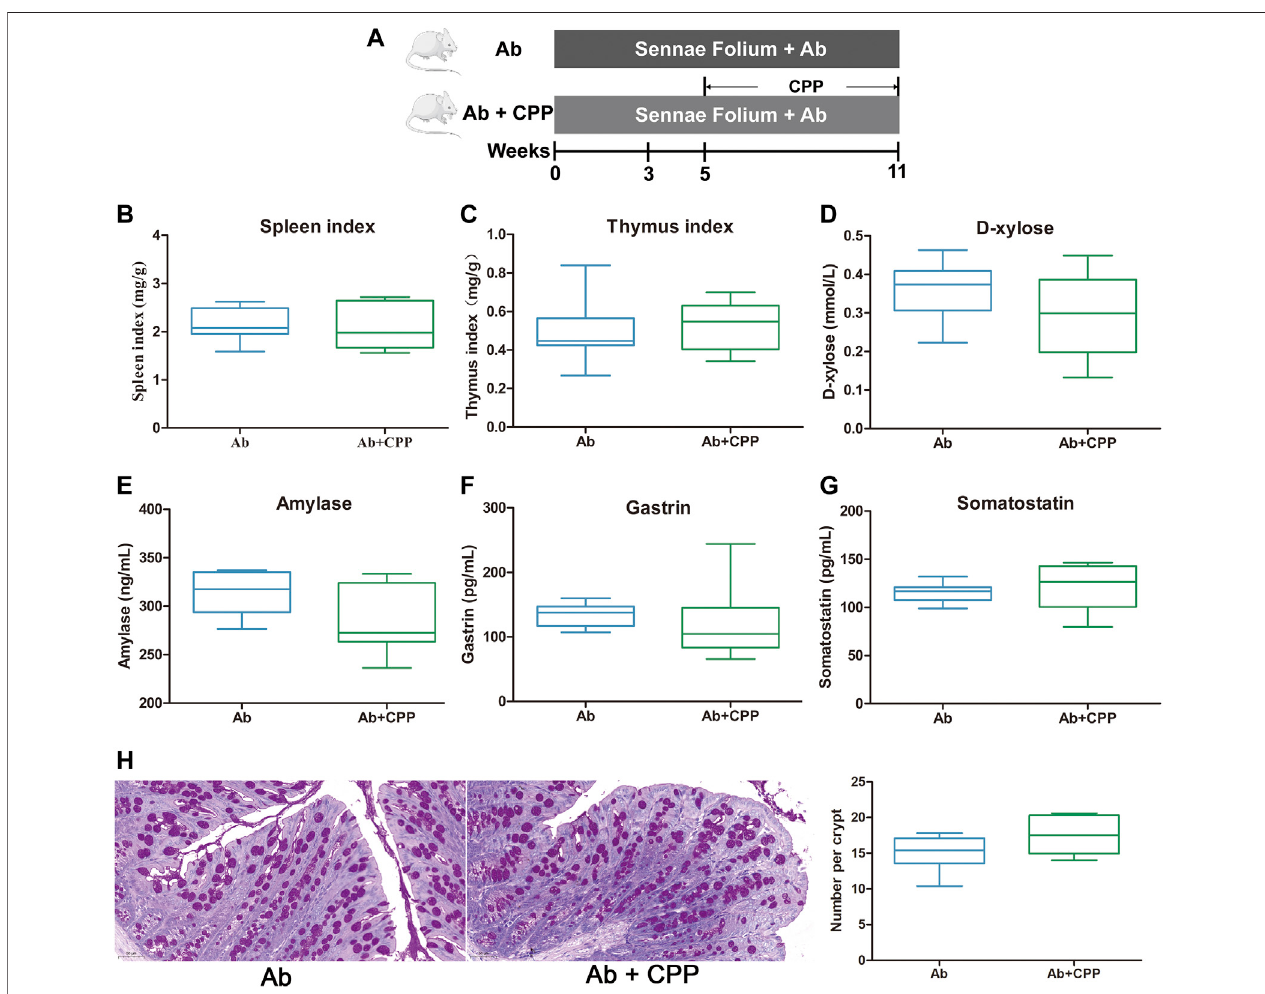
FIGURE 3 | SDS remission effects of CPP depend on intestinal microbiota. Boxplots provide range, mean, minimum and maximum value. (A) Timeline of experimental process of mice in each group. (B) Effect of CPP on spleen index. (C) Changes in thymus index. (D) Serum concentration of D -xylose. (E) Serum levels of amylase re fl ecting digestive ability. (F) Serum concentration of GAS. (G) Serum concentration of SS. (H) Representative PAS-stained colonic sections (×200 magni fi cation)ineach group;and number ofgoblet cells percrypt ineach group. Datawereexpressed asmean ±SEM( n =8 – 10).Ab, antibioticgroup. Ab +CPP: antibiotic + Codonopsis pilosula polysaccharide treatment